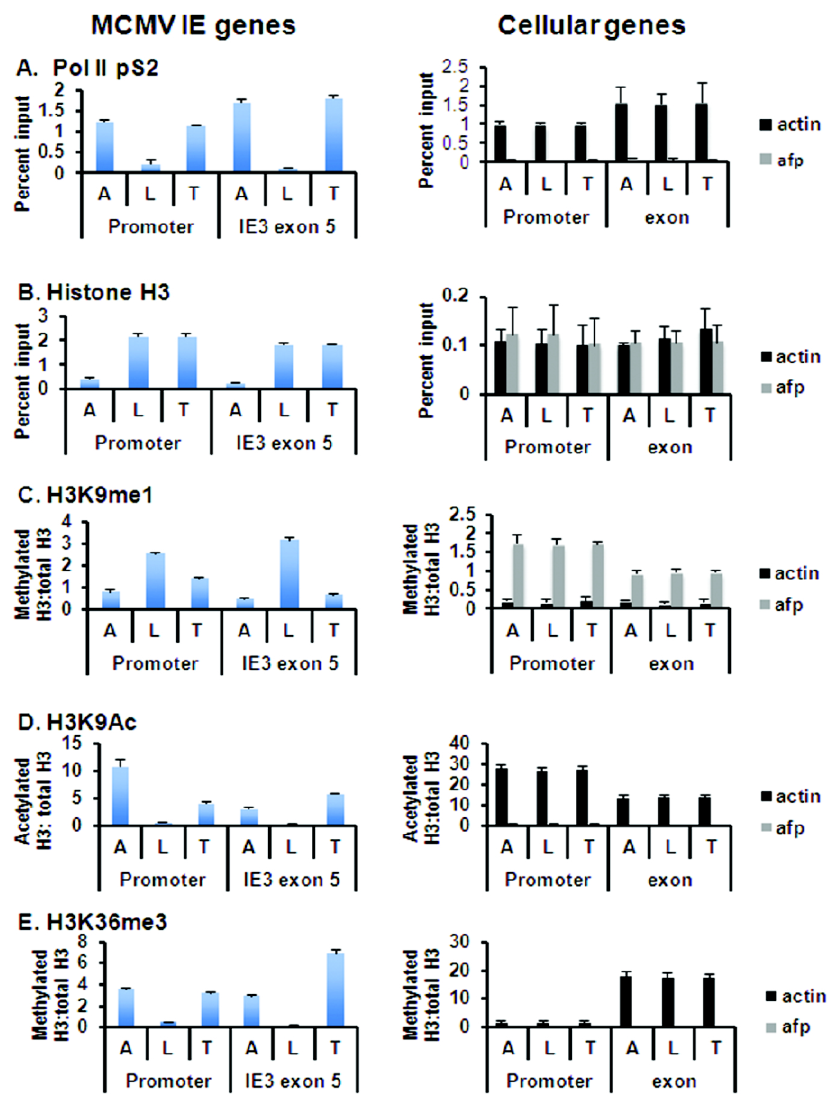
We first analyzed binding of RNA polymerase II (Pol II) to the ie region. Pol II can bind to promoter regions as pre-initiation complexes, and thus, binding to the promoter does not necessarily indicate active transcription [86]. However, phosphorylation of S2 of the carboxy terminal domain (Pol II pS2) is associated with transcriptional elongation, and thus, active transcription. The MCMV ie region encodes two differentially spliced transcripts, IE-1, containing exons 1, 2, 3, and 4, and IE-3, containing exons 1, 2, 3, and 5 [87]. We analyzed binding of Pol II pS2 to both the ie promoter